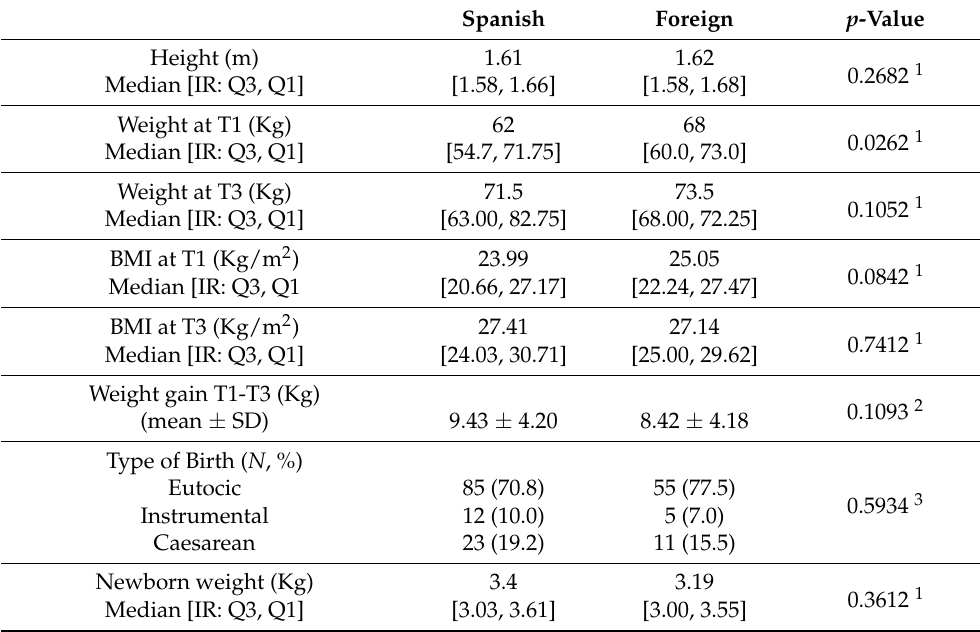
Table 4. Anthropometric characteristics and obstetric data of women included in the study.